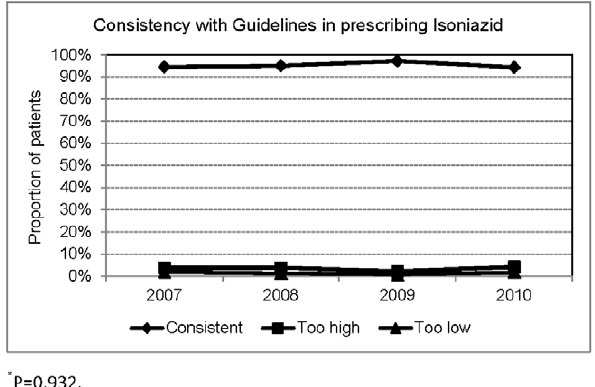
Figure 6. Consistency with Taiwan Guidelines in prescribing